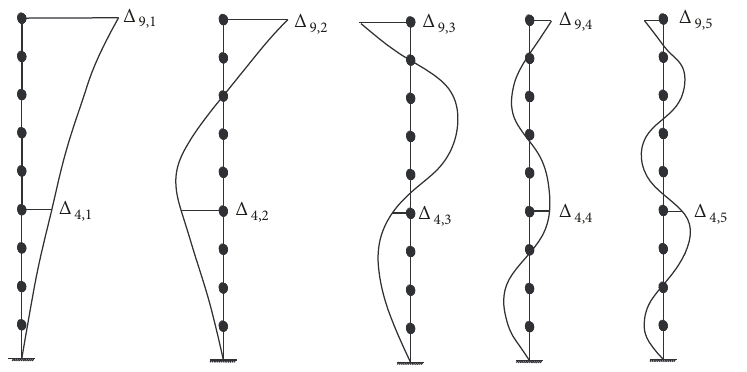
Figure 8: The first five mode